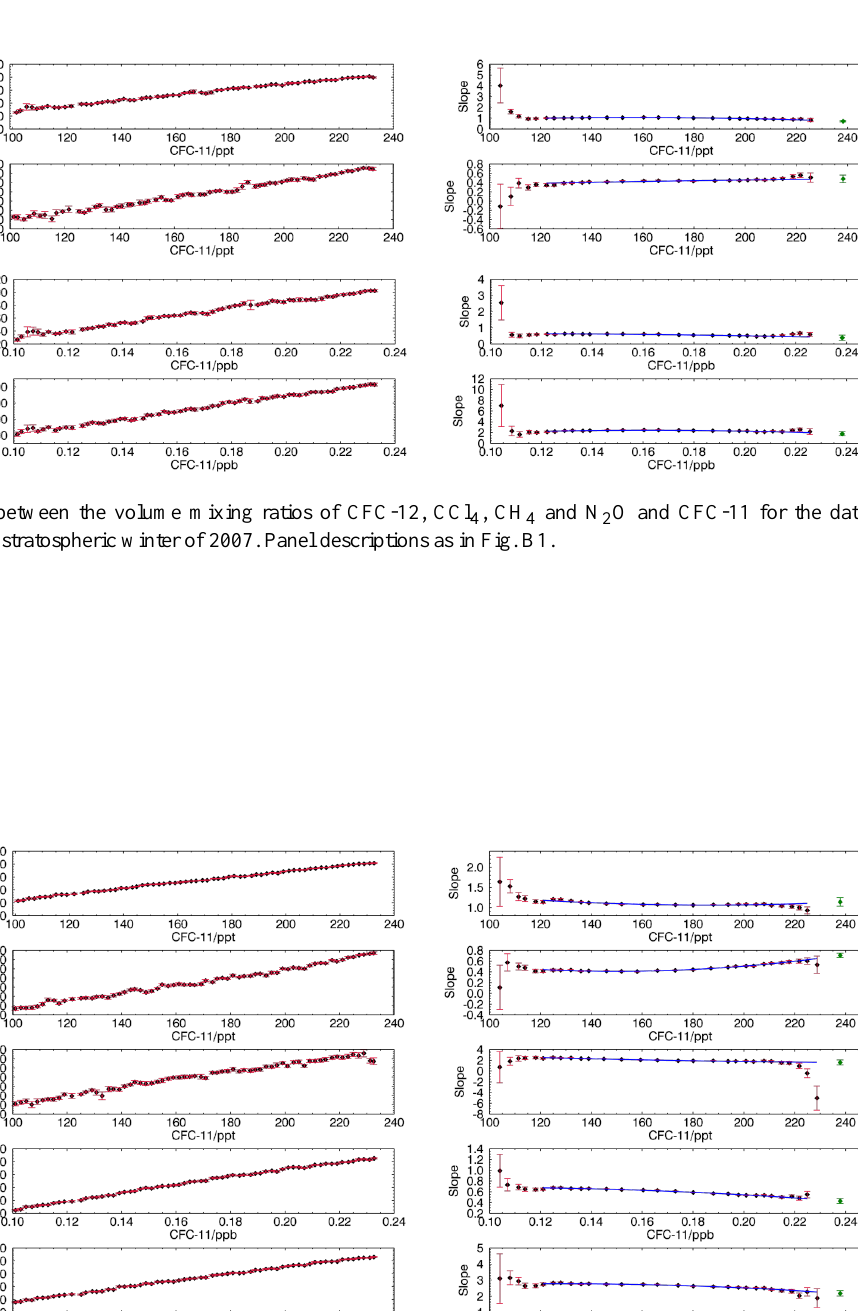
Figure B9 Correlations between the volume mixing ratios of CFC-12, CCl 4 , CH 4 , CH 3 Cl and N 2 O and CFC-11 for the data from the northern hemisphere during the stratospheric winter of 2008. Left panels: The mean correlation profile. Each point represents the mean of the VMR in a window of 2 ppt of CFC-11. The error on these points is the standard deviation of the data within each 2 ppt window. Right panels: The local slope of data in an 80 ppt of CFC-11 window. The error on the points is the fitting error of this fit. The blue line is a second degree polynomial fit to the local slopes. The green point is the extrapolated slope at the tropopause.